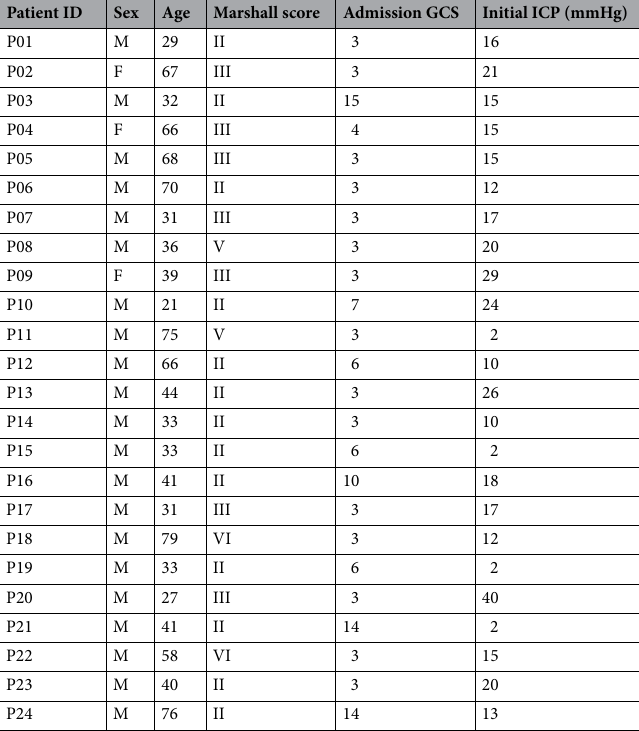
Table 1. Overview and admission status of the measured TBI patients (P01–P24): Marshall CT classification score, Glasgow Coma Scale (GCS) and the initial ICP (mmHg) after catheter